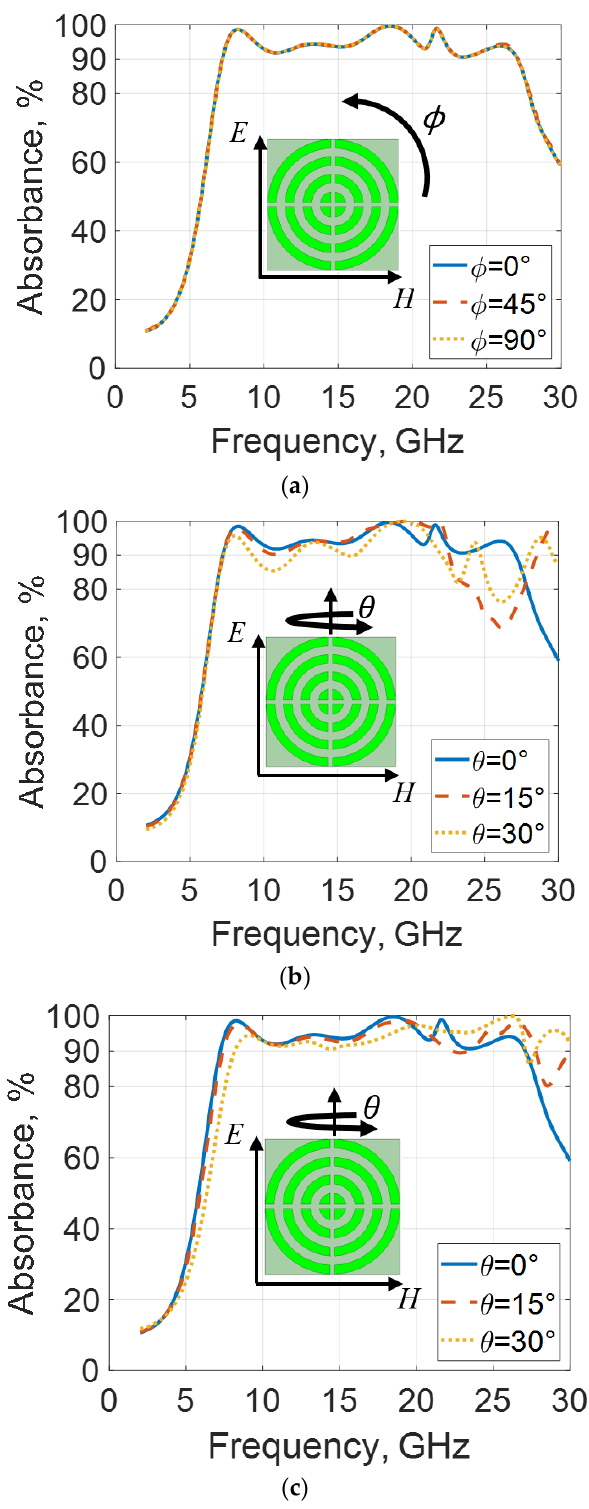
Figure 6. Simulated absorbance. ( a ) For various polarizations (TEM mode), ( b ) for various incidence angles (TE mode), and ( c ) for various incidence angles (TM mode).